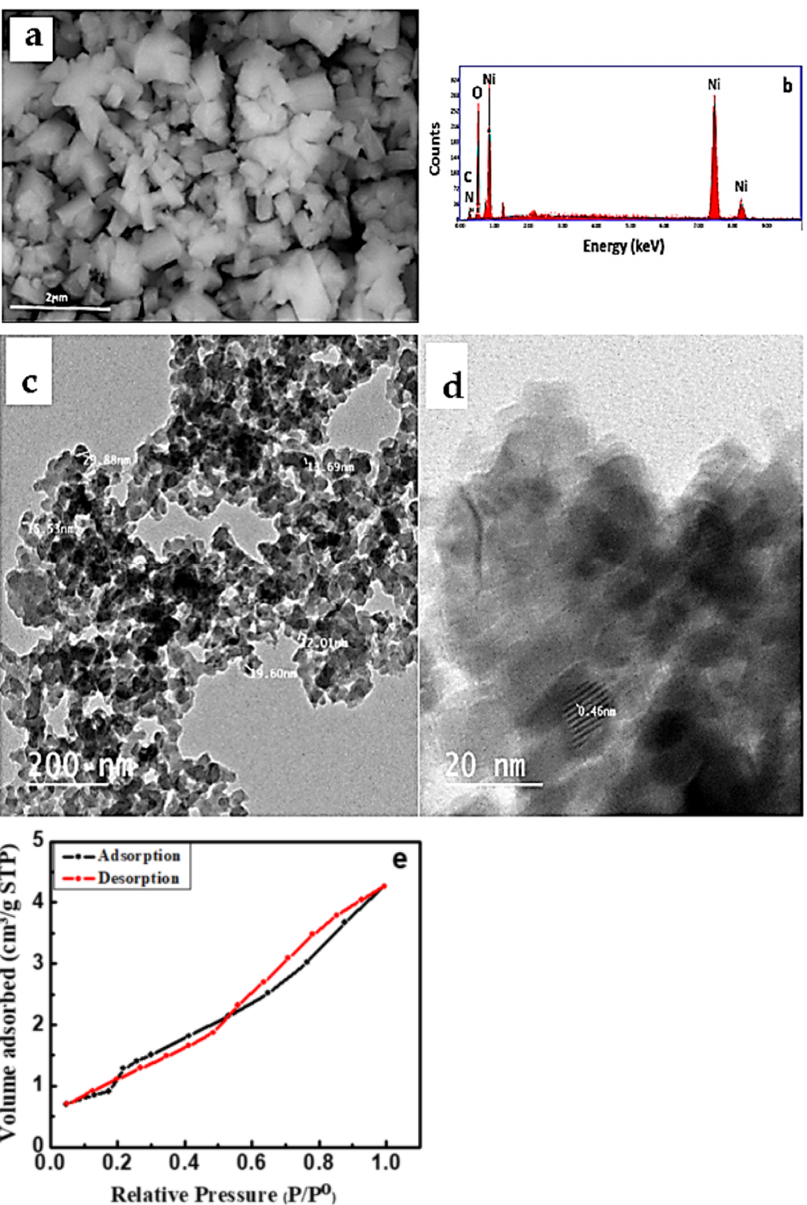
Figure 3. ( a ) SEM micrograph, ( b ) EDX spectra of NiO/PDA nanocomposite, ( c ) TEM ( d ) HRTEM images of NiO/PDA nanocomposite, ( e ) nitrogen adsorption/desorption isotherm for NiO/PDA nanocomposite. Table 1. EDX analysis of NiO/PDA